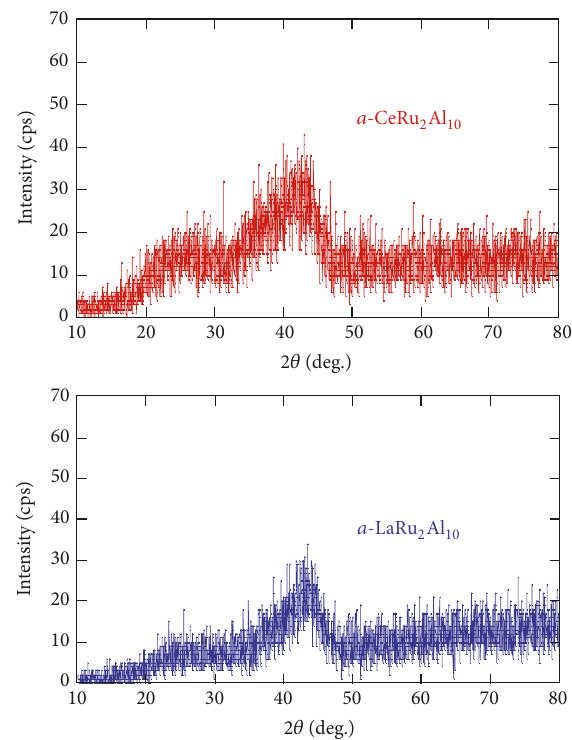
Figure 1: X-ray diffraction pattern of a -CeRu 2 Al 10 and a -LaRu 2 Al 10 alloys.